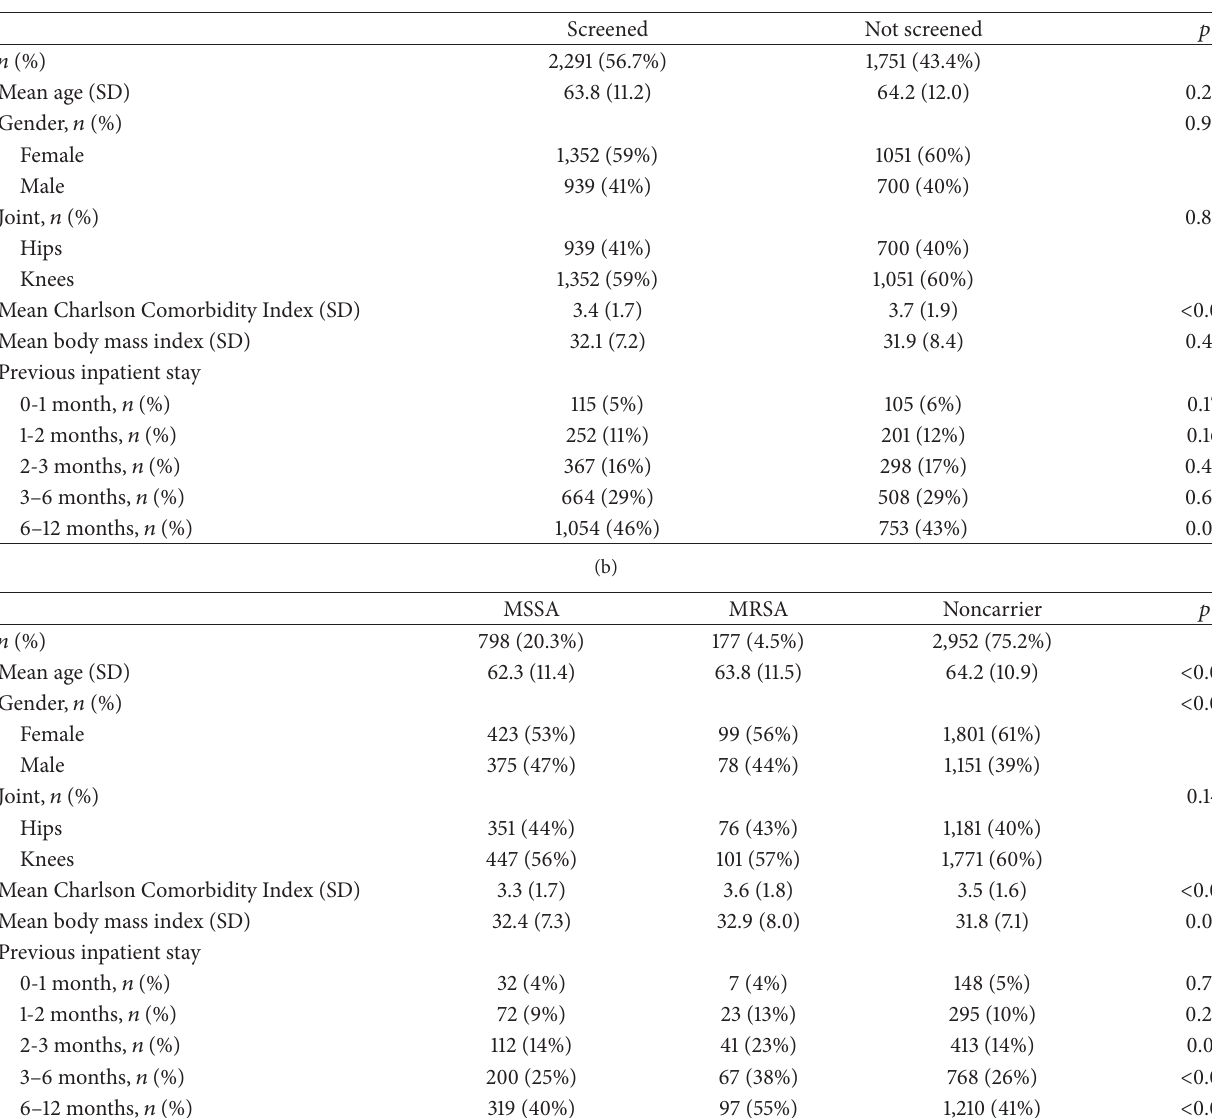
Table 1: (a) Demographics and clinical characteristics of all total knee and total hip patients between October 2011 and March 2013 ( 𝑛 = 4,042), with follow-up of at least one year, grouped by screening status. (b) Demographics and clinical characteristics of all total knee